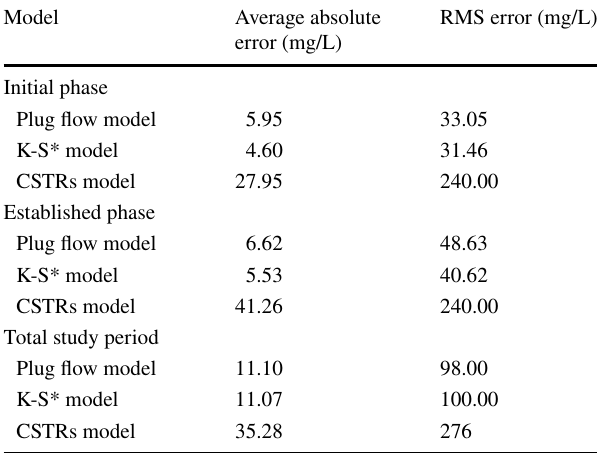
5 concentration